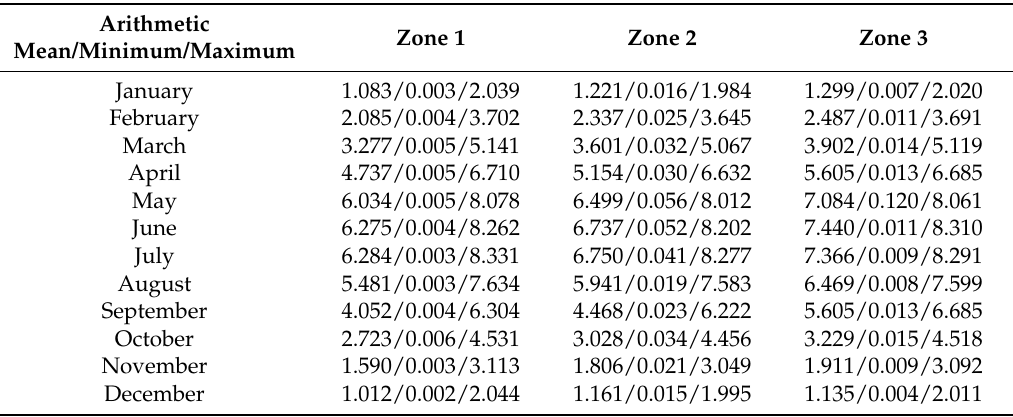
Table 2. Descriptive statistics for the radiation values of the three zones: The arithmetic mean, the minimum radiation, and the maximum radiation (expressed in kWh/m 2